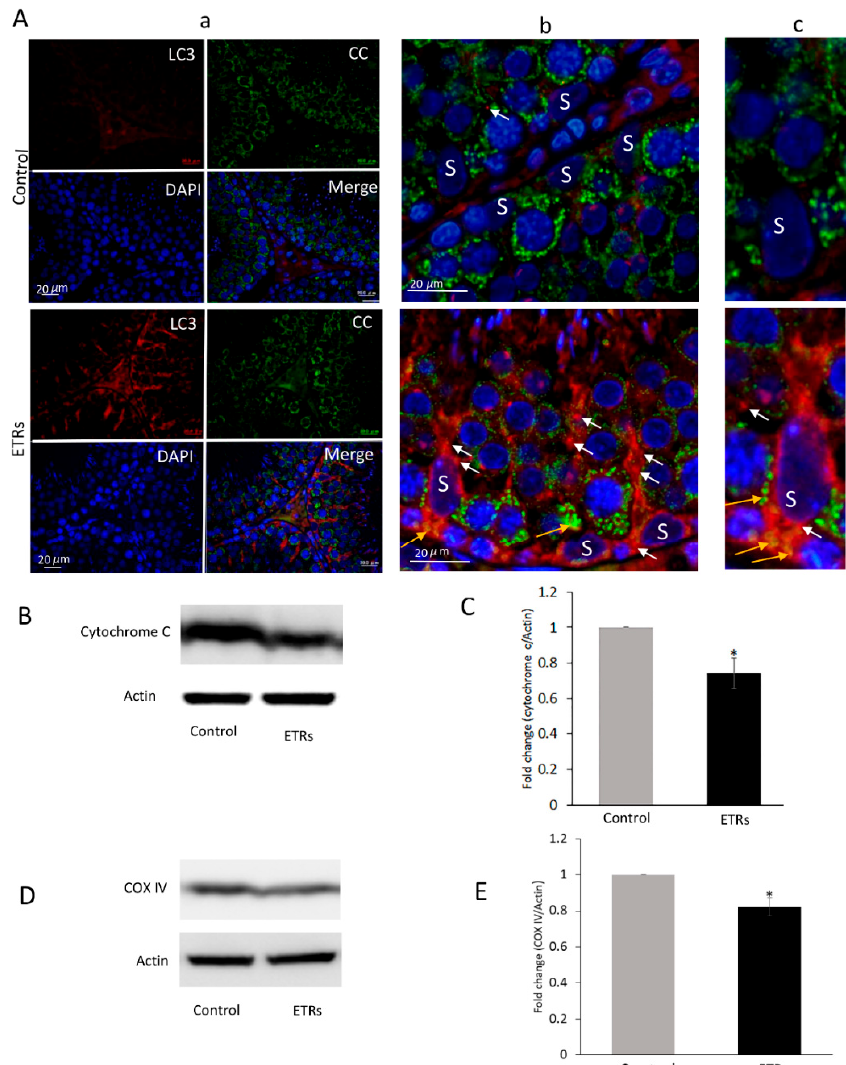
Figure 3. Enhanced colocalization of LC3 with cytochrome c in SCs of ETRs and reduced expression of mitochondrial proteins. ( A ) Immunofluorescence (IF) double-labeling of LC3 (red) and cytochrome c (CC) (green) with nuclear counterstaining using DAPI (blue). The panels in the middle ( b ) and on the right ( c ) are higher magnifications of those on the left in ( a ). Orange arrows indicate areas of colocalization for proteins (yellow-orange), while white arrows indicate LC3 puncta. S: SC nucleus. ( B ) Western blot of CC ( n = 3). The histogram in ( C) shows significant reduction of CC in ETRs. ( D ) Western bot of Cytochrome c oxidase (COX) IV ( n = 3). The histogram in E shows significant reduction of the protein in ETRs * p < 0.05 ( t -test).